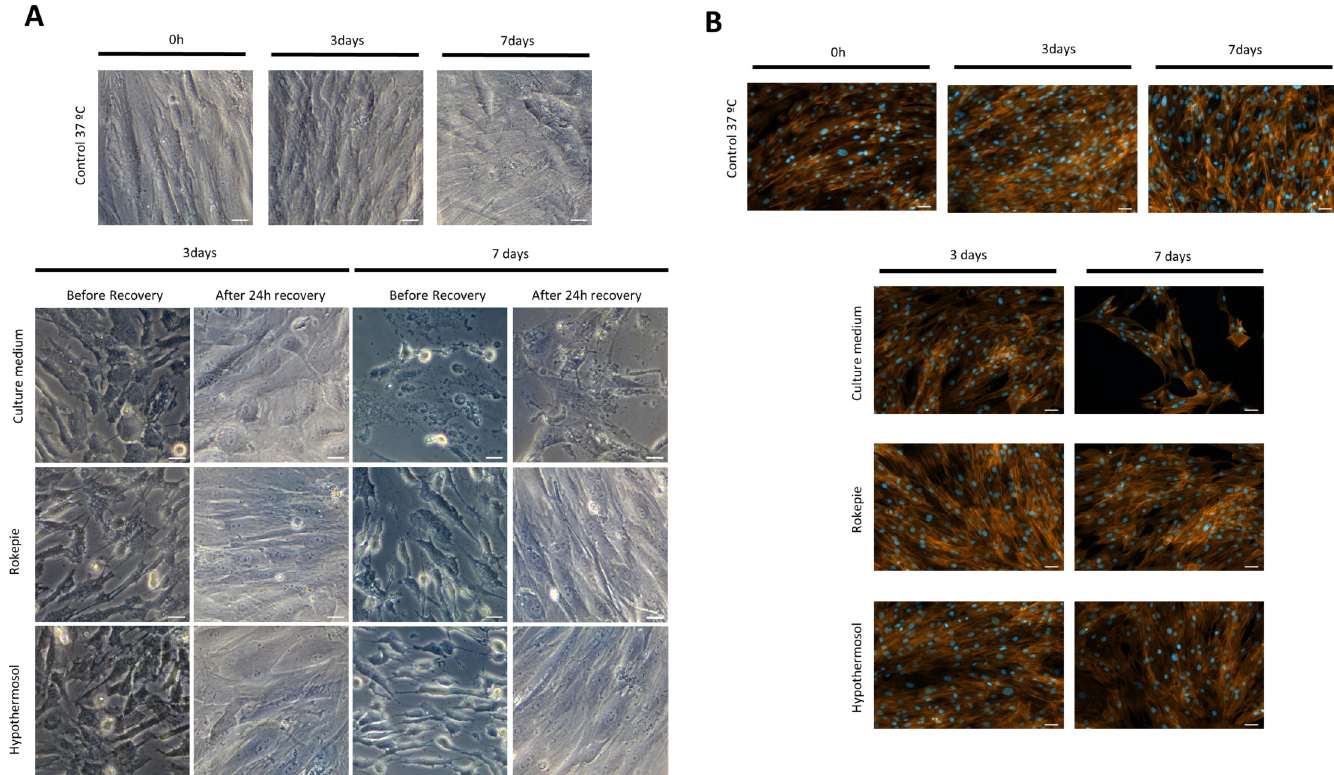
Fig 3. Brightfield and phalloidin staining images. Representative images of confluent hASCs preserved at 4˚C, in the presence and absence (Culture medium) of hypothermic storage solutions for 3 and 7 days. Images of control culture at 37˚C was also included. Values for 0 hours correspond to cells before 4˚C incubation A) Morphology assessment at the end of preservation period, and after a respective recovery period of 24 hours. B) Phalloidin staining for the actin filaments (orange) performed after cultures being subjected to a recovery period of 24 hours. Cell nuclei were counterstained with DAPI (blue). Scale bar: 50 μ